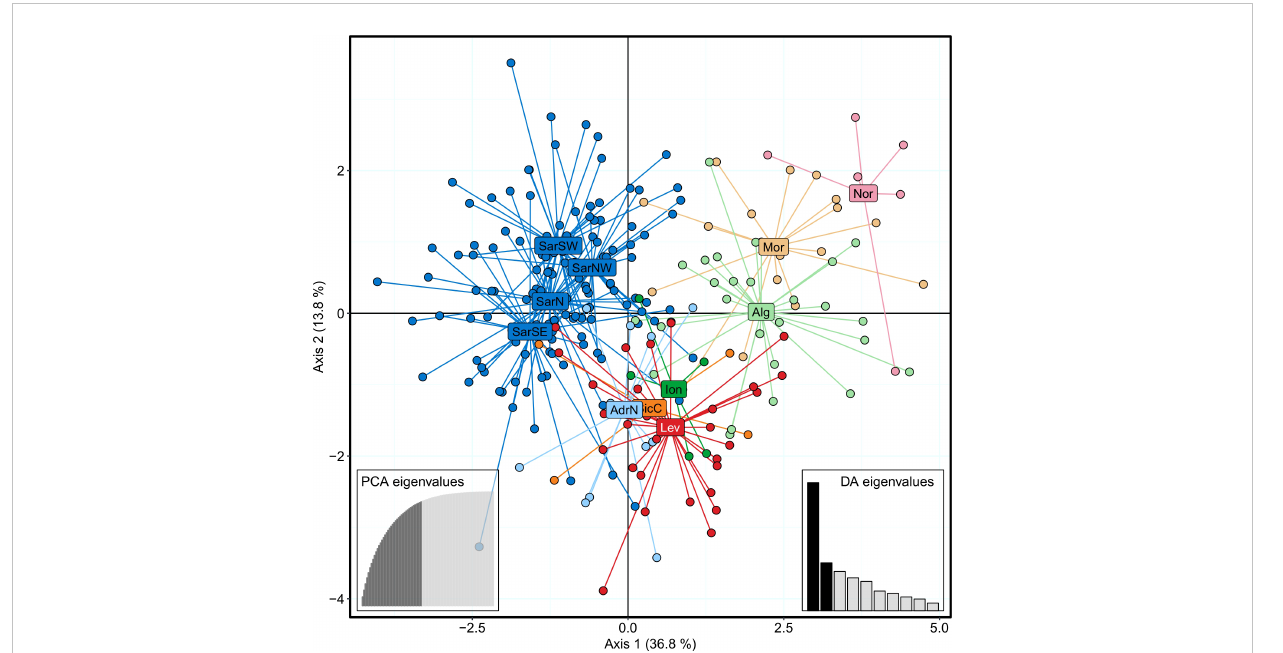
FIGURE 3 DAPC scatterplot for Scyliorhinus canicula samples, colored according to the BAPS plot in Figure 2. Abbreviations are in accordance with Figure 1.